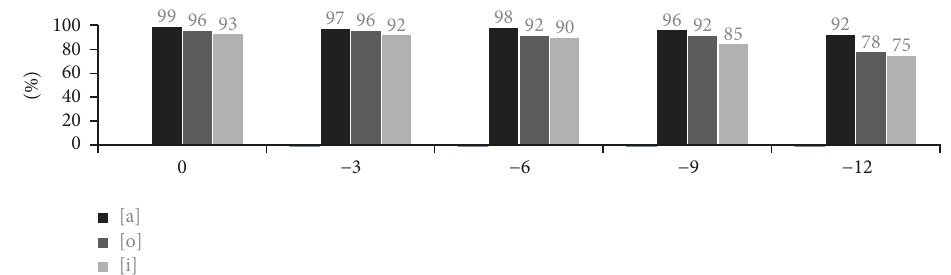
Figure 12: Correct recognition of vowels in first stressed syllable against white